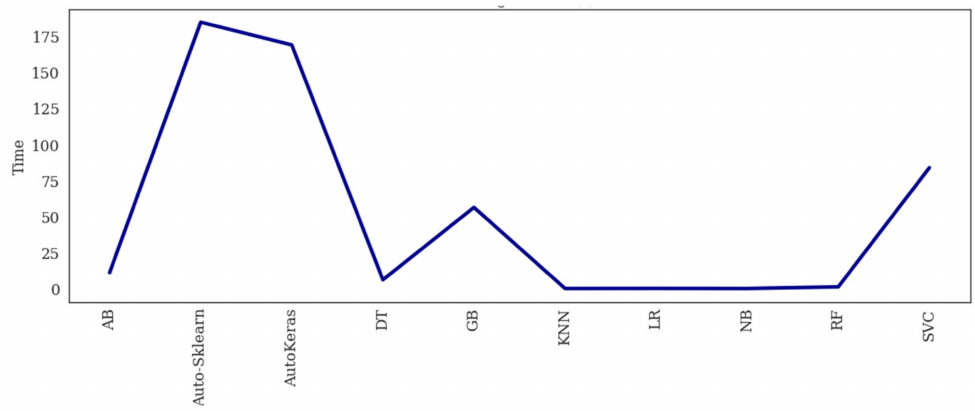
Figure 11. The computational time in the 5-level severity classification